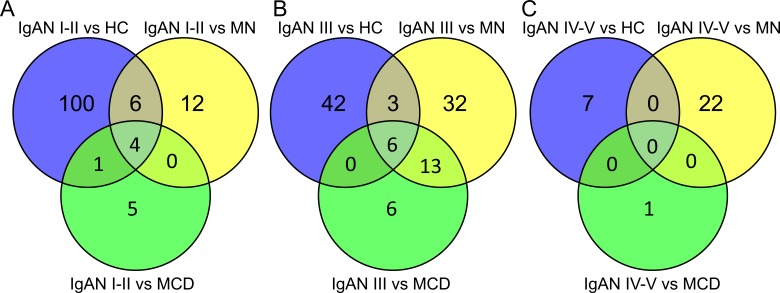
Overlapping relationship of the differentially expressed miRNAs in IgAN subgroups.Urinary levels of miRNAs in the subgroups of IgAN (IgAN grade I–II, III and IV–V subgroup according to Lee’s grading system) were compared with each control group (HC, MN and MCD) in the screening phase. All differentially expressed miRNAs presented a fold change >2 and P value <0.05. The miRNAs in the centre of Venn diagram were (A) miR-223-3p, miR-629-5p, miR-3613-3p and miR-4668-5p; (B) miR-150-5p, miR-572, miR-371b-5p, miR-3613-3p, miR-4668-5p and miR-6750-5p. IgAN, IgA nephropathy; HC, healthy control; MN, membranous nephropathy; MCD, minimal change disease.